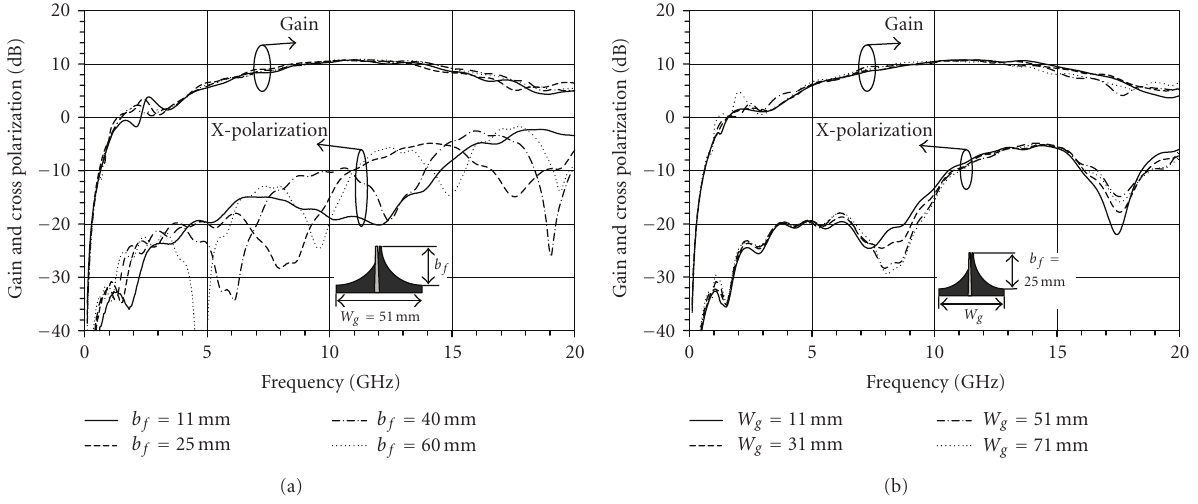
Figure 8: Gain and cross polarization with di ff erent ground profiles of feeding